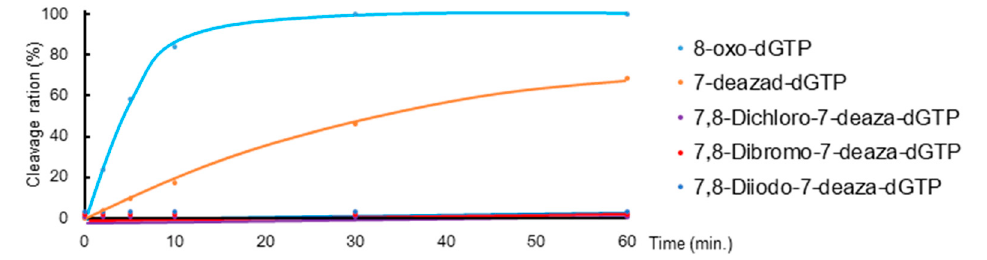
Figure 2. Time courses of the hydrolysis of 8-oxo-dGTP, 7-deaza-dGTP, and 7,8-dihalogenated-7-deaza-dGTP ( 9 , 10 , and 11 ) by MTH1. Reaction conditions: 20 mM Tris-HCl pH 7.5, 4 mM MgCl 2 , 40 mM NaCl, 80 μ g/mL bovine serum albumin (BSA), 8 mM dithiothreitol (DTT), 10% glycerol; 50 μ M 8-oxo-dGTP, 5 nM MTH1; 50 μ M dNTPs; incubated at 37 °C for various times. Hydrolysis reactions were analyzed by HPLC, and the cleavage rate was calculated from the peak area.